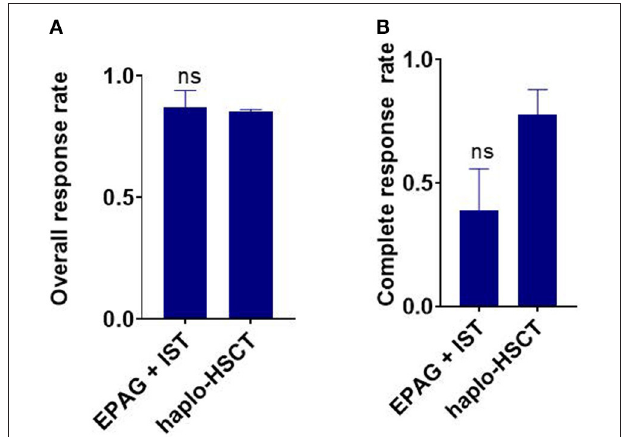
FIGURE 3 | Indirect comparison the overall response rate (ORR) and complete response (CR) rate between EPAG + IST and haplo-HSCT group in age-matched population. (A) Bar plots show similar ORR between the two groups. ns, p > 0.05, based on the Student t -test. (B) Bar plots show similar ORR between the two groups. ns, p > 0.05, based on the Student t -test. EPAG, eltrombopag; IST, immunosuppressive therapy; haplo-HSCT, haploidentical hematopoietic stem cell